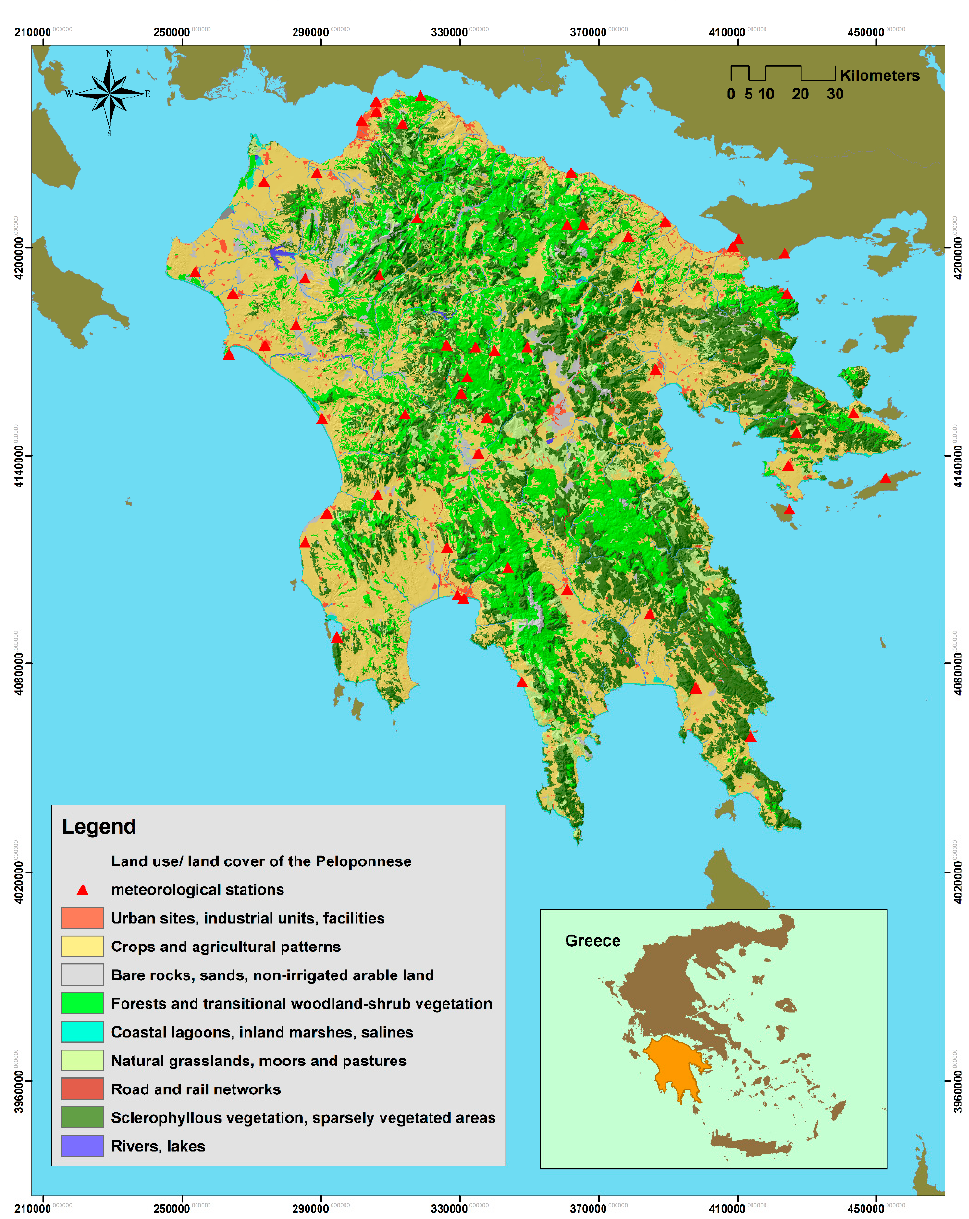
Figure 1. LULC map of the Peloponnese (Adapted with permission from ref. [63] 2018, © European Union).